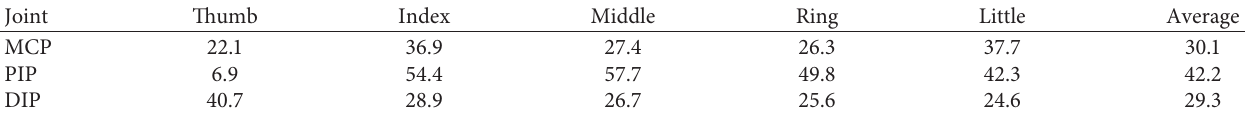
Figure 11: Variations of DIP Joint angle over time (index finger, experiment versus theory). Table 5: Average value of the maximum joint angle of our joints at different voltages ( ° ).